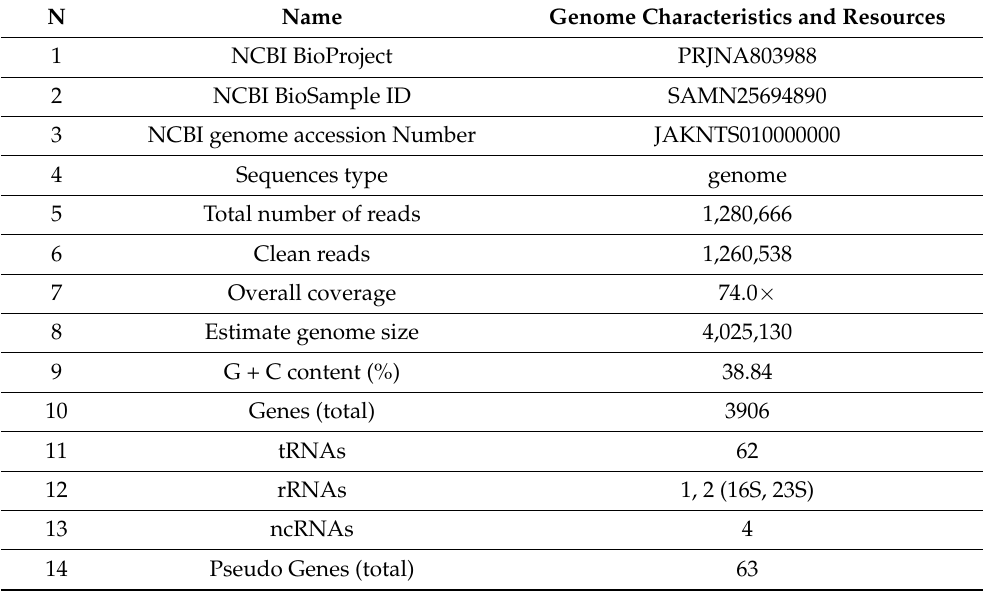
Table 2. Genome characteristics and